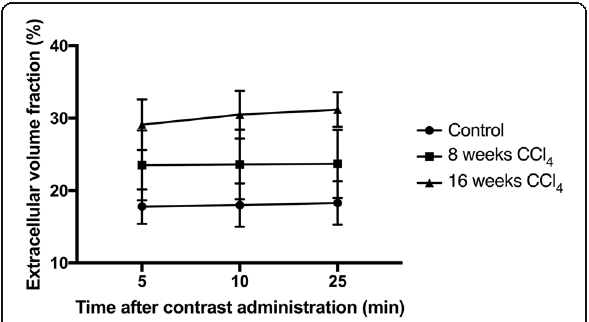
Fig. 2 Change on mean extracellular volume (ECV) fraction measurements over time. Measurements are given for the control group and for the 8 and 16 weeks carbon-tetrachloride (CCl 4 )